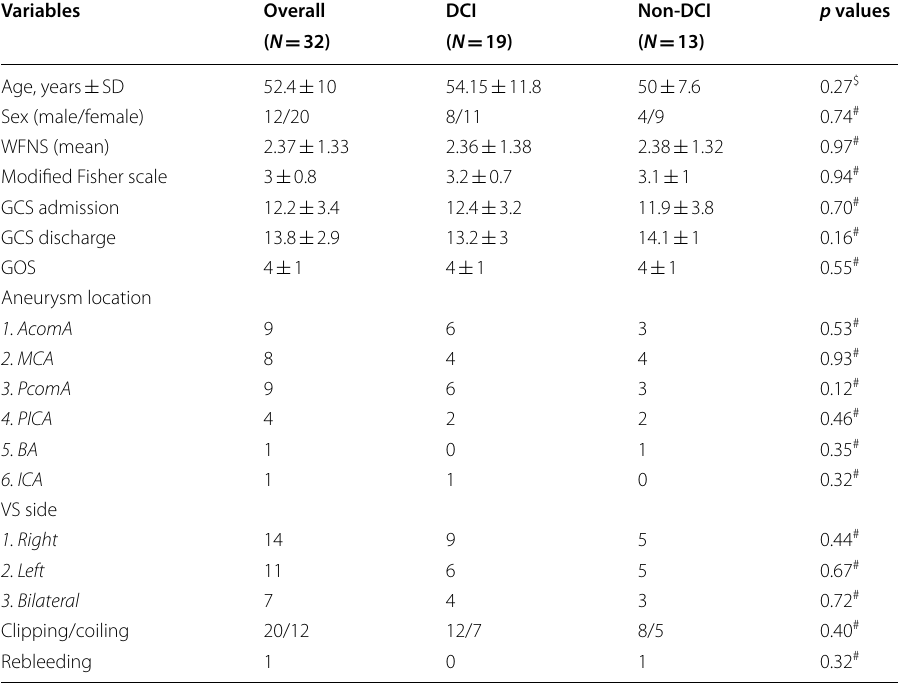
Table 1 Characteristics of all patients and subgroups with and without DCI